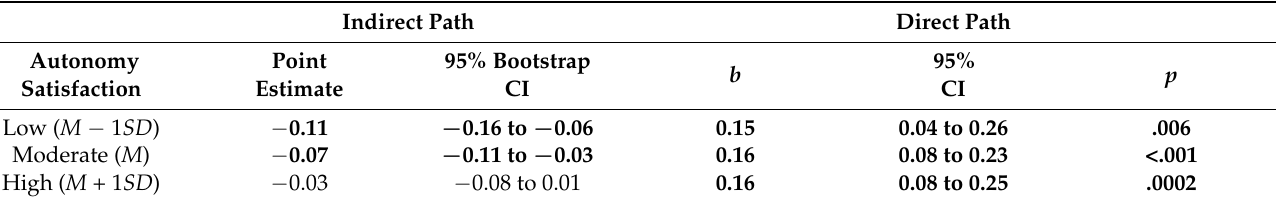
Table 2. Conditional direct and indirect